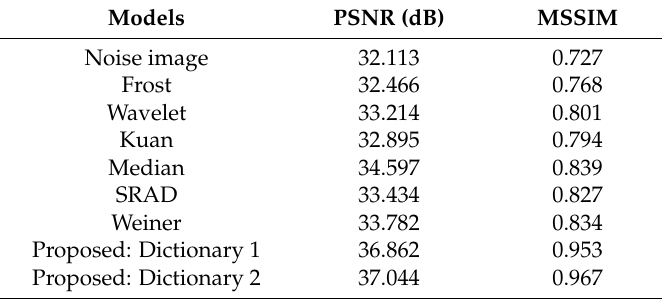
Figure 4. ( a ) Original image; ( b ) noisy image. Results of the proposed method with ( c ) Dictionary 1 and ( d ) Dictionary 2; Results of the ( e ) Frost; ( f ) wavelet; ( g ) Kuan; ( h ) median; ( i ) Weiner; and ( j ) speckle reducing anisotropic diffusion (SRAD) filters. Table 1. Peak signal-to-noise ratio (PSNR) and mean structural similarity (MSSIM) for the synthetic images for σ = 10.